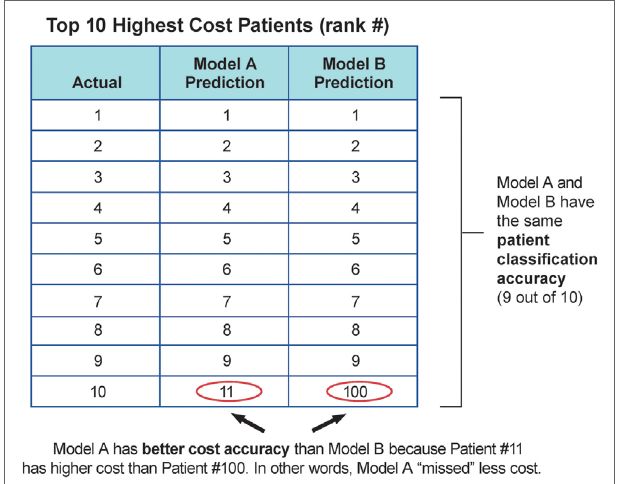
FigUre 2 | Troy example to demonstrate the value of cost accuracy, in addition to patient classification